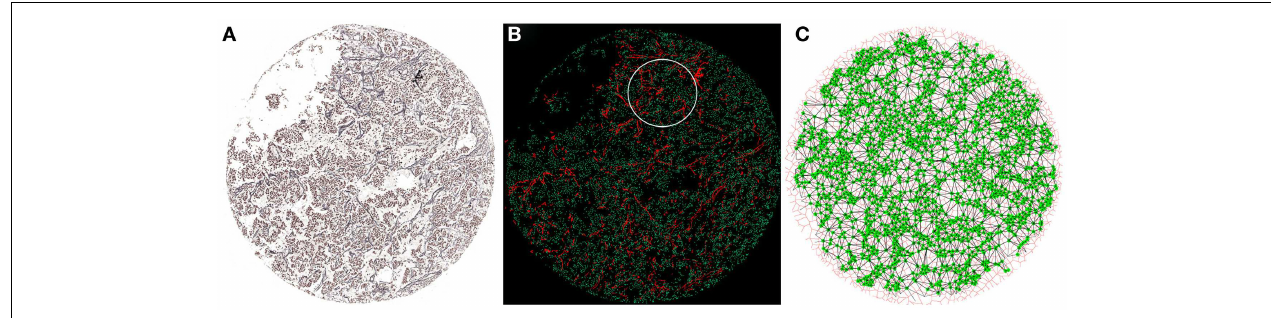
nucleus (green) is taken as a seed to build aVoronoi diagram (red) of Voronoi cells.This allows the creation of a network of cell-to-cell contacts (black lines) that can be used to extract topological characteristics of the